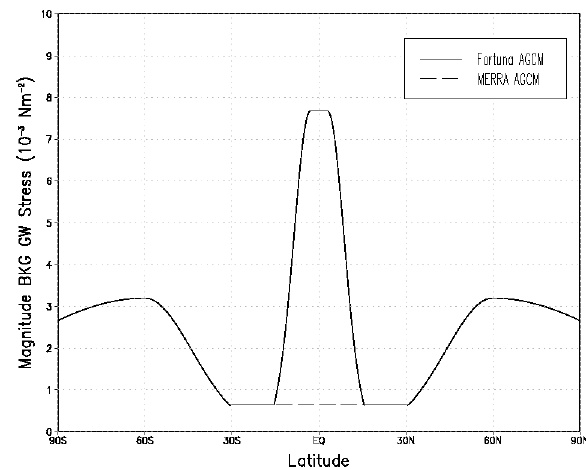
Figure 1 : Background non–orographic gravity wave drag in the Q simulation (shown as the solid black line) and N simulation (shown as the dashed black line). Reproduced with permission from Molod et al. (2012).